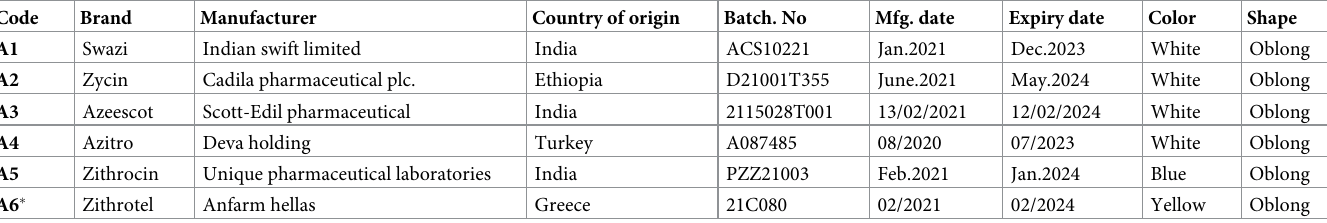
Table 1. A detailed label information of different brands of Azithromycin 500 mg tablets evaluated in the study